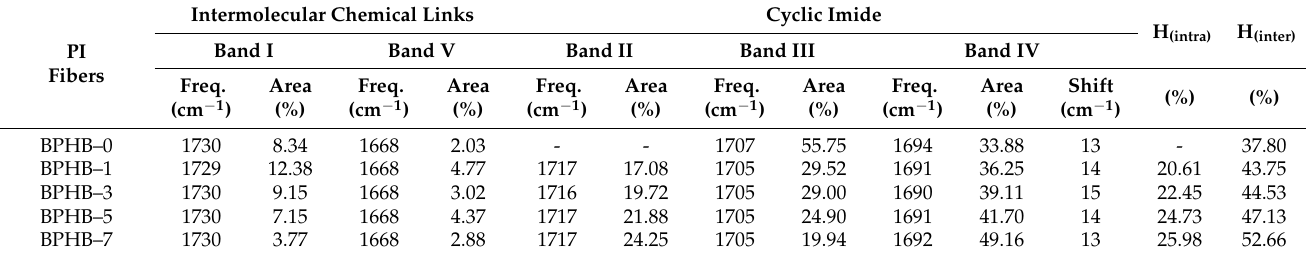
Table 2. Calculated results of curve-fitting ATR–FTIR spectra in the wavenumber range from 1650 cm − 1 to 1750 cm − 1